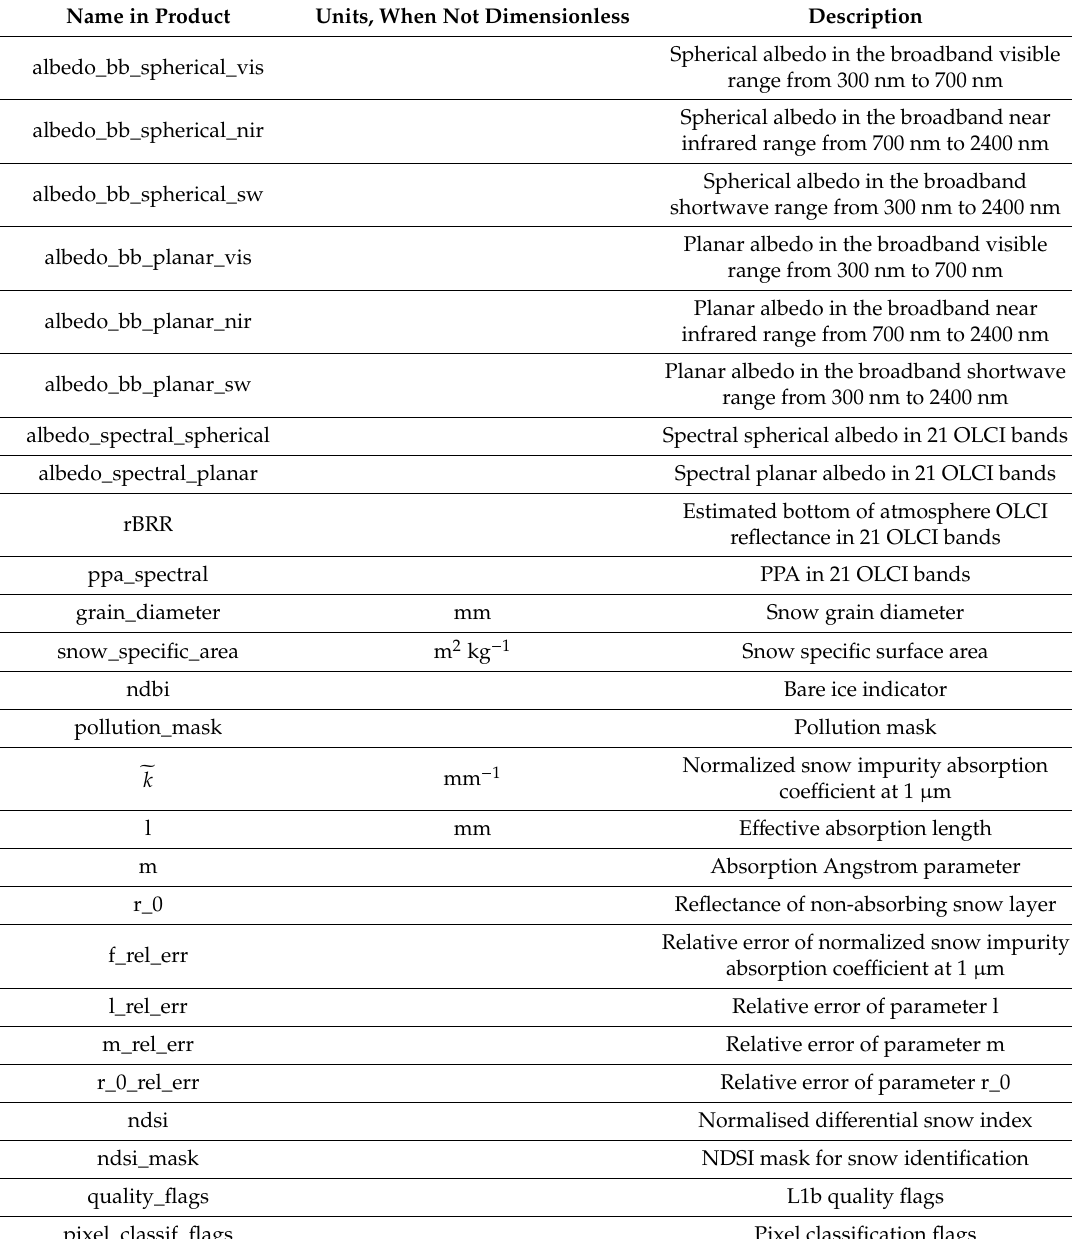
Table 1. Bands in the final snow properties